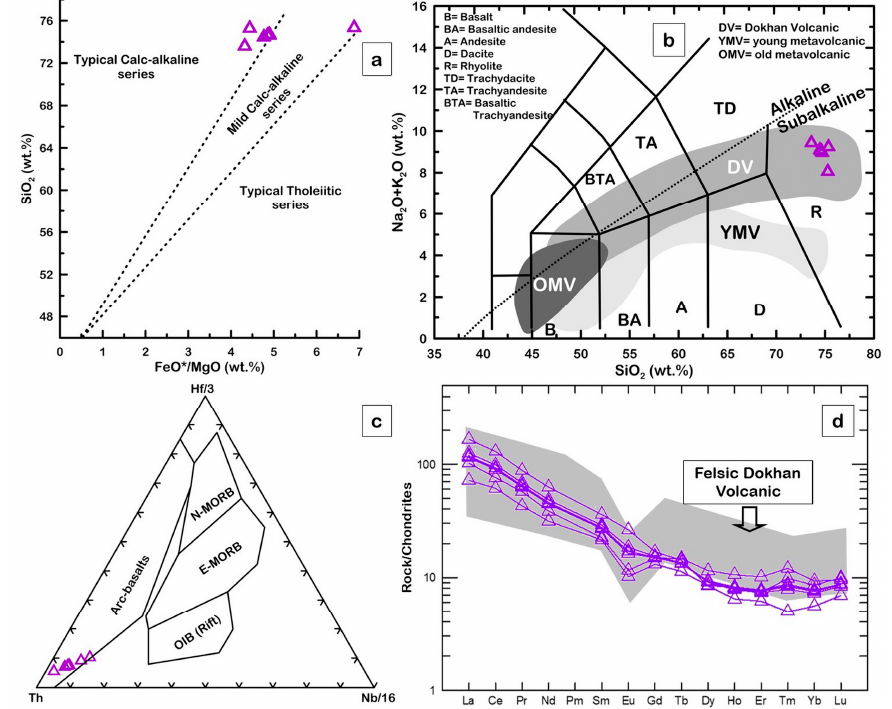
Figure 11. ( a ) FeO*/MgO vs. SiO 2 diagram for the studied metavolcanics and felsite dike [47]. ( b ) Total alkalis vs. silica (TAS) diagram for the geochemical classification of the studied felsite dike [43]. The boundary between alkaline and subalkaline fields after Irvine and Baragar [48]. For comparison, a field for Dokhan volcanics (DV) from Moghazi [44] and Eliwa et al. [23], and fields for older and younger metavolcanics (OMV and YMV) from Stern [49]. ( c ) Hf/3-Th-Nb/16 tectonomagmatic discrimination diagram for the metavolcanic and felsite dike samples [45]. ( d ) Chondrite-normalized REE patterns [46]. For comparison, a field of the felsic Dokhan Volcanics from Moghazi [44] and Eliwa et al. [23]. Table 2. Major oxides, trace, and REE of the felsite dikes of Abu Zawal (Fatira)